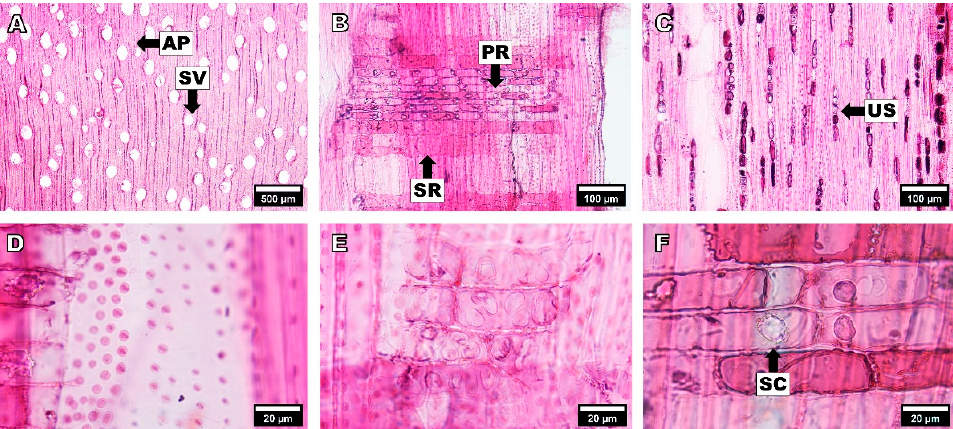
Figure 6. Optical micrographs of Melaleuca cajuputi . Cross-section ( A ), radial section ( B ), tangential section ( C ), intervessel pits ( D ), vessel-ray pits ( E ), and mineral inclusions ( F ). Solitary vessel (SV), axial parenchyma (AP), procumbent body ray (PR), square body ray (SR), upright body ray (UR), uniseriate ray (US), and silica bodies (SC).